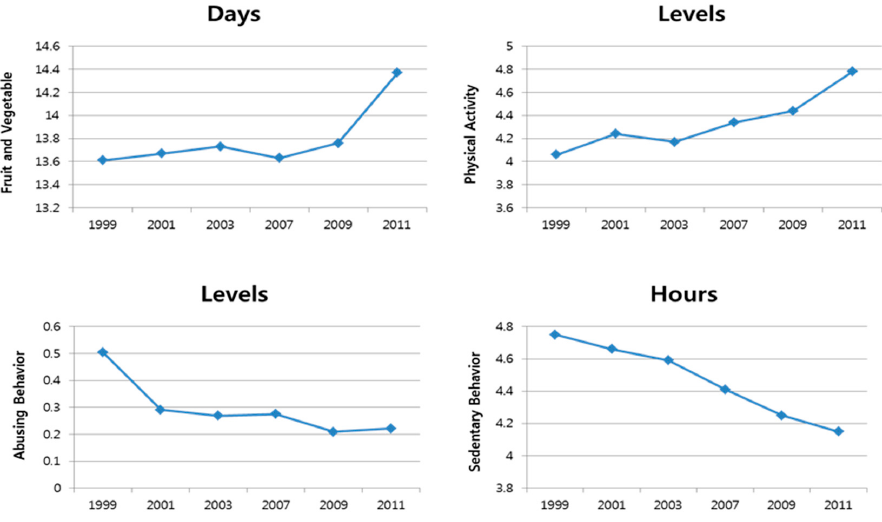
Figure 3. Variable scores by years.